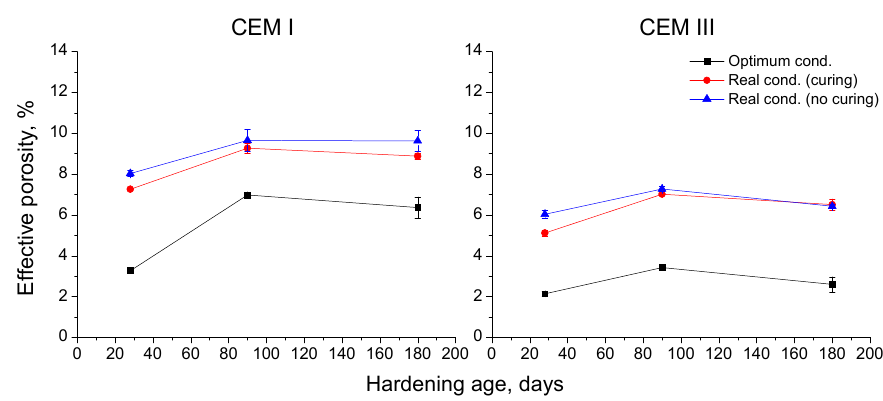
Figure 8. Results of effective porosity for concretes made with CEM I and CEM III.